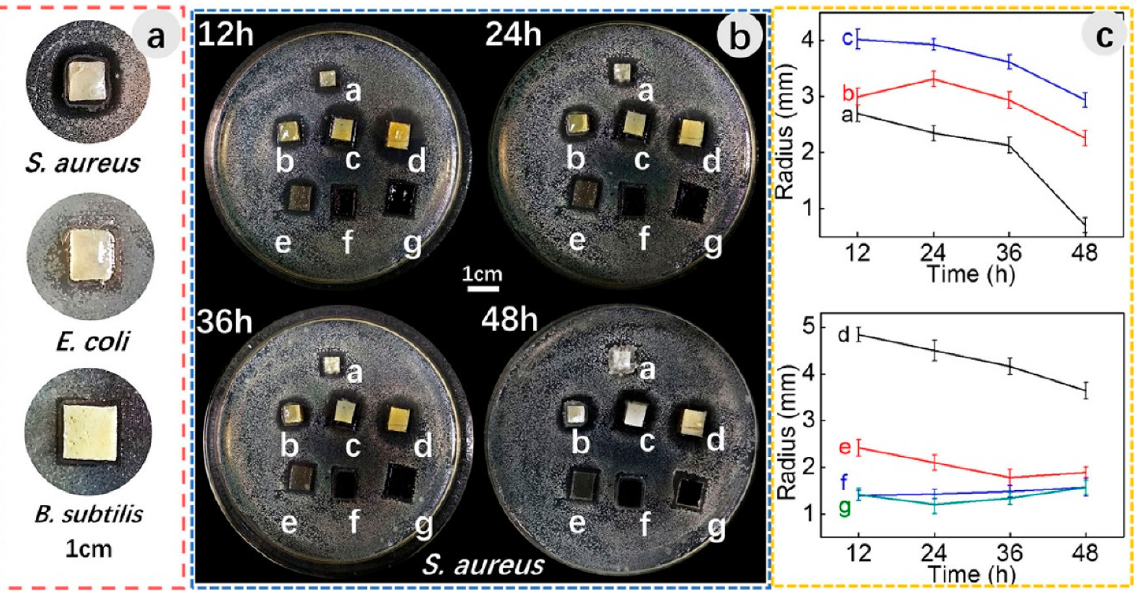
Figure 16. ( a ) Bacteriostasis of CS/PVA/GO0/Alli1 composites against various bacteria. ( b ) Bacteriostasis of distinctive composites against S. aureus over time. ( c ) The alteration of bacteriostatic circle diameter of various composites over time. Sample: a: CS/PVA/GO0/Alli0; b: CS/PVA/GO0/Alli0.5; c: CS/PVA/GO0/Alli1; d: CS/PVA/GO0/Alli2; e: CS/PVA/GO0.1/Alli2; f: CS/PVA/GO0.3/Alli2; g: CS/PVA/GO0.5/Alli2 [268]. Reproduced with permission from ref [268]. Copyright 2020 Elsevier.